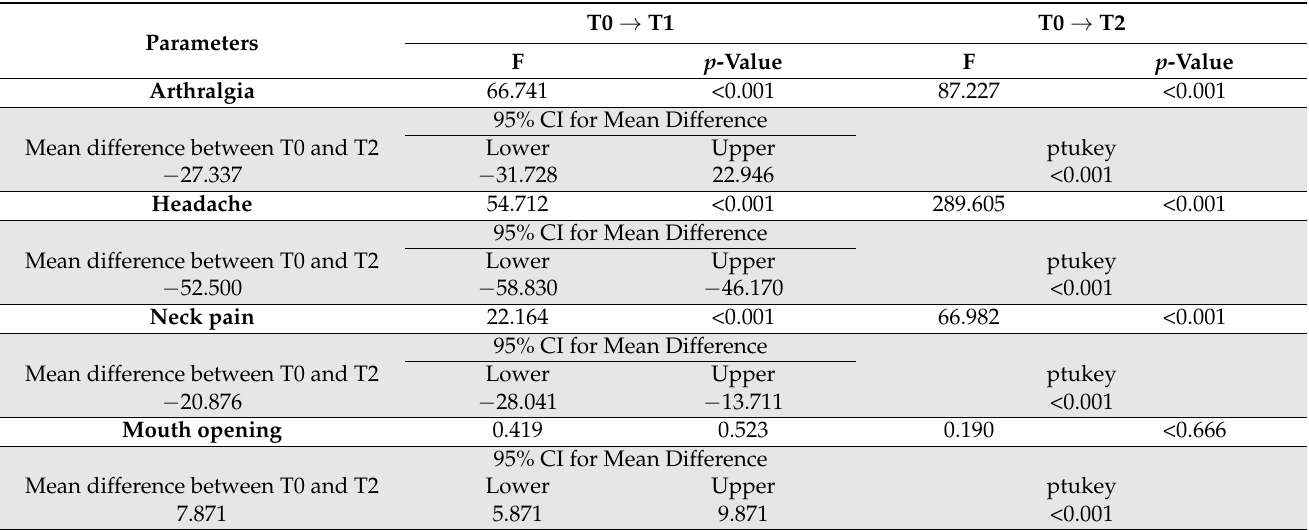
Table 4. Analysis of covariance for T0/T1 and T0/T2 with an ANCOVA test, with statistical signif- icance set at p < 0.05. Mean difference between T0 and T2 with a 95% CI between RA.DI.CA and stabilization splints for each pain and functional parameter.